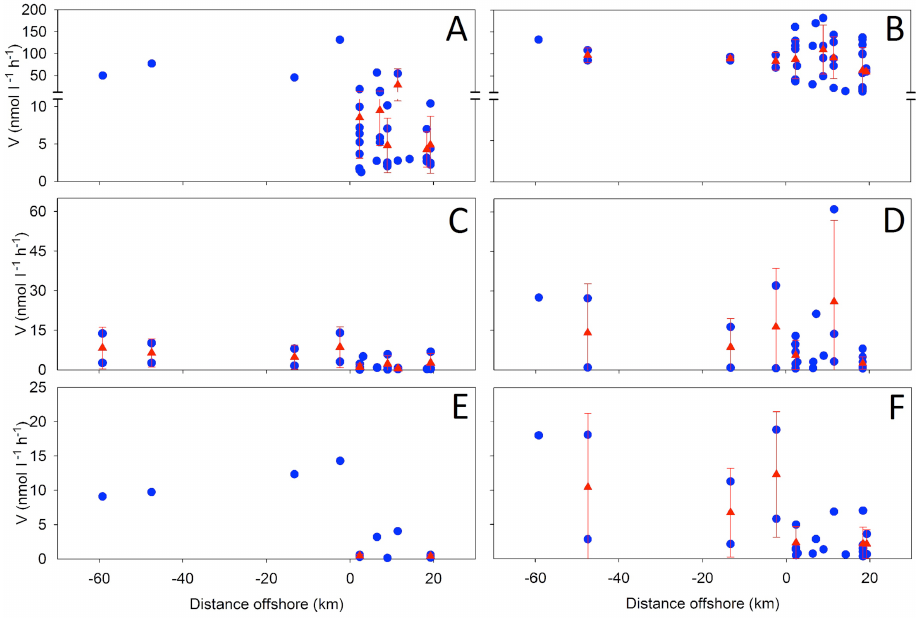
781 Fig. 5. Enzymatic extracellular hydrolysis of substrates MCA-leu ( A, B ), MUF-glu ( C, D ), MUF-cel ( E, F ) in surface waters during the winter (left panels) and spring-summer (right panels) in relation to distance from the coast (negative distances represent river sampling sites). Rates are in nmoll − 1 h − 1 . Blue symbols are discrete values and red symbols are average rates ( ± SD) if possible.